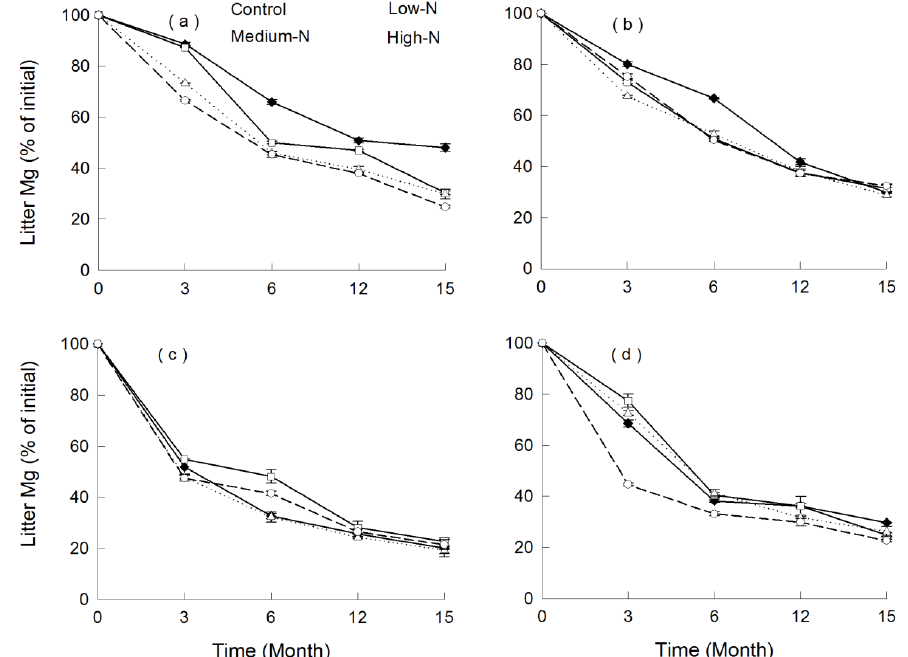
Figure 6. Mean litter magnesium (Mg, % of initial) amount with standard error over time in the decomposition of each leaf litter under N addition treatments. ( a ) Chinese pine litter in the plantation; ( b ) Chinese pine litter in the natural forest; ( c ) Mongolian oak litter in the natural forest; and ( d ) Pine-oak litter in the natural forest.